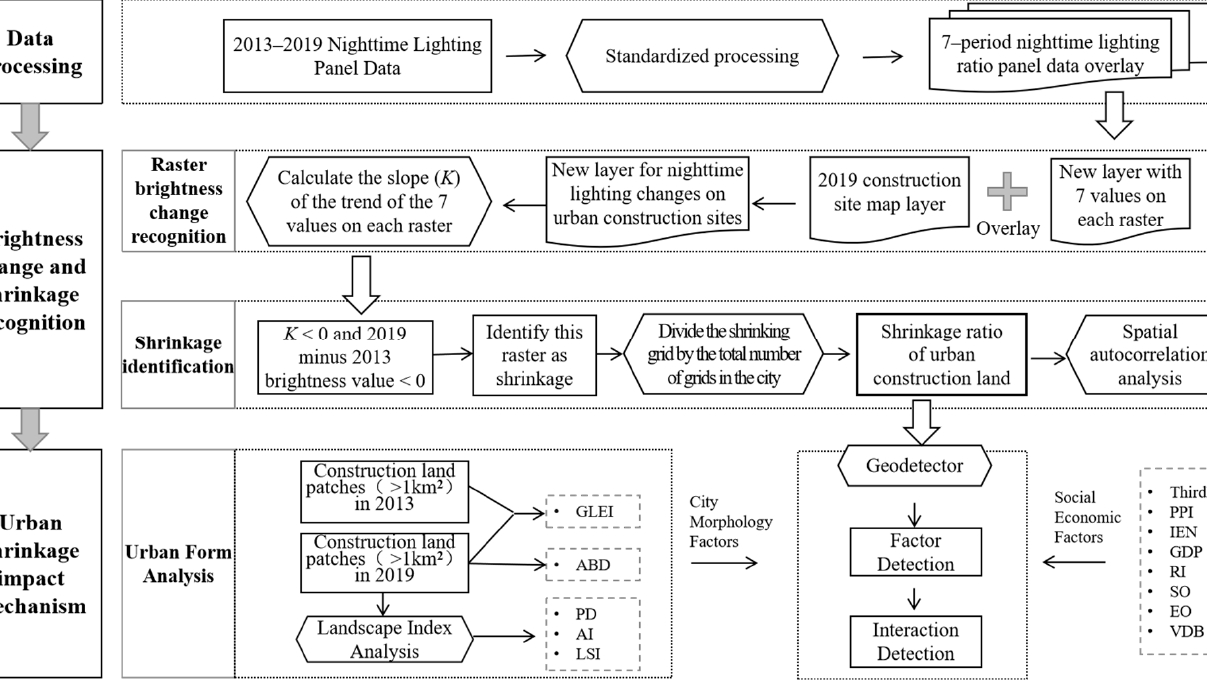
Figure 2. Research framework diagram.